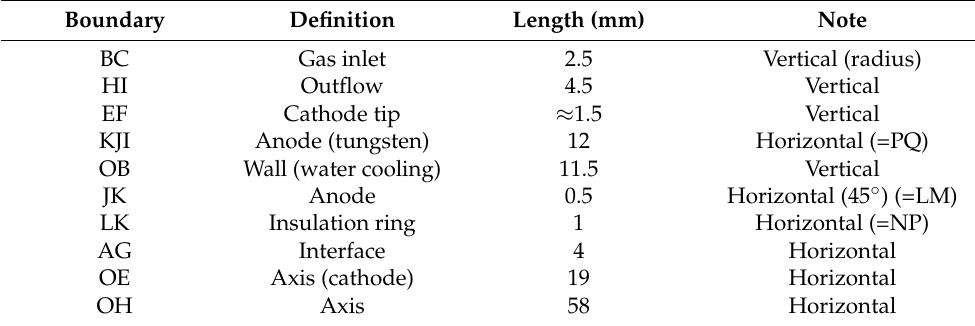
Table 2. Characteristic lengths of main boundaries of SinplexPro™ gun arcing simulation.